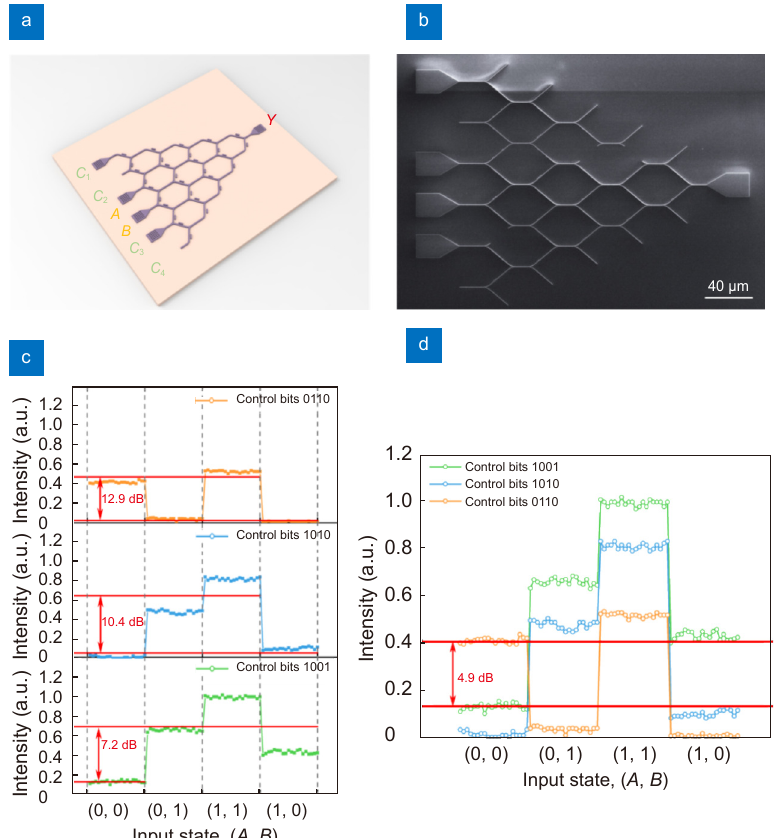
Fig. 4 | Multifarious logic gates. ( a ) Schematic diagram of the multifarious logic gate operator. Ports A , B are the signal inputs, and ports C 1 , C 2 , C 3 , C 4 , together constitute the control bits, and Y represents the signal output. ( b ) Top-view SEM image of the multifarious logic gate operat- or. ( c ) 0−1 intensity distribution when the optical CNN device acts as three different types of logic gates. ( d ) Overlay of three logic function re- sponses in the optical CNN structure. The top red line corresponds to the minimum intensity of “1”, and the bottom red line shows the maximum intensity of